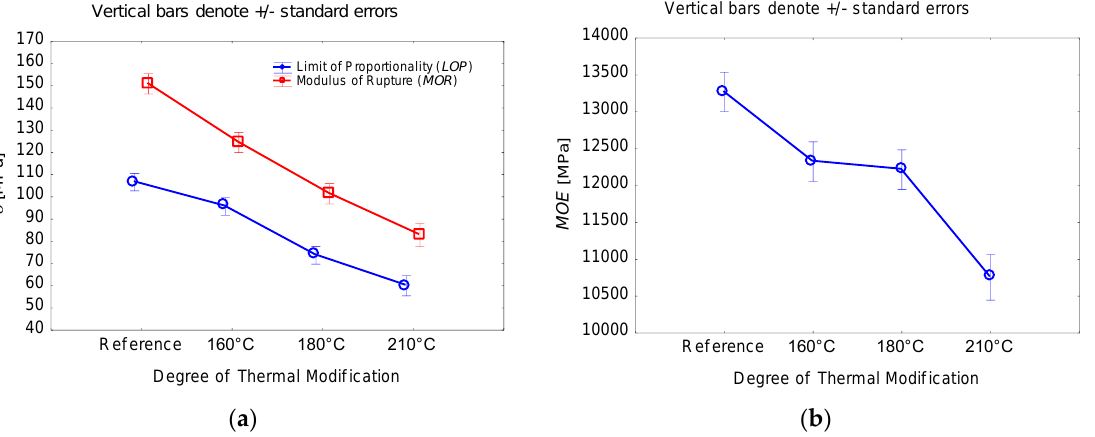
Figure 1. ( a ) The effect of thermal modification on the LOP and MOR values; ( b ) the effect of thermal modification on the MOE values.